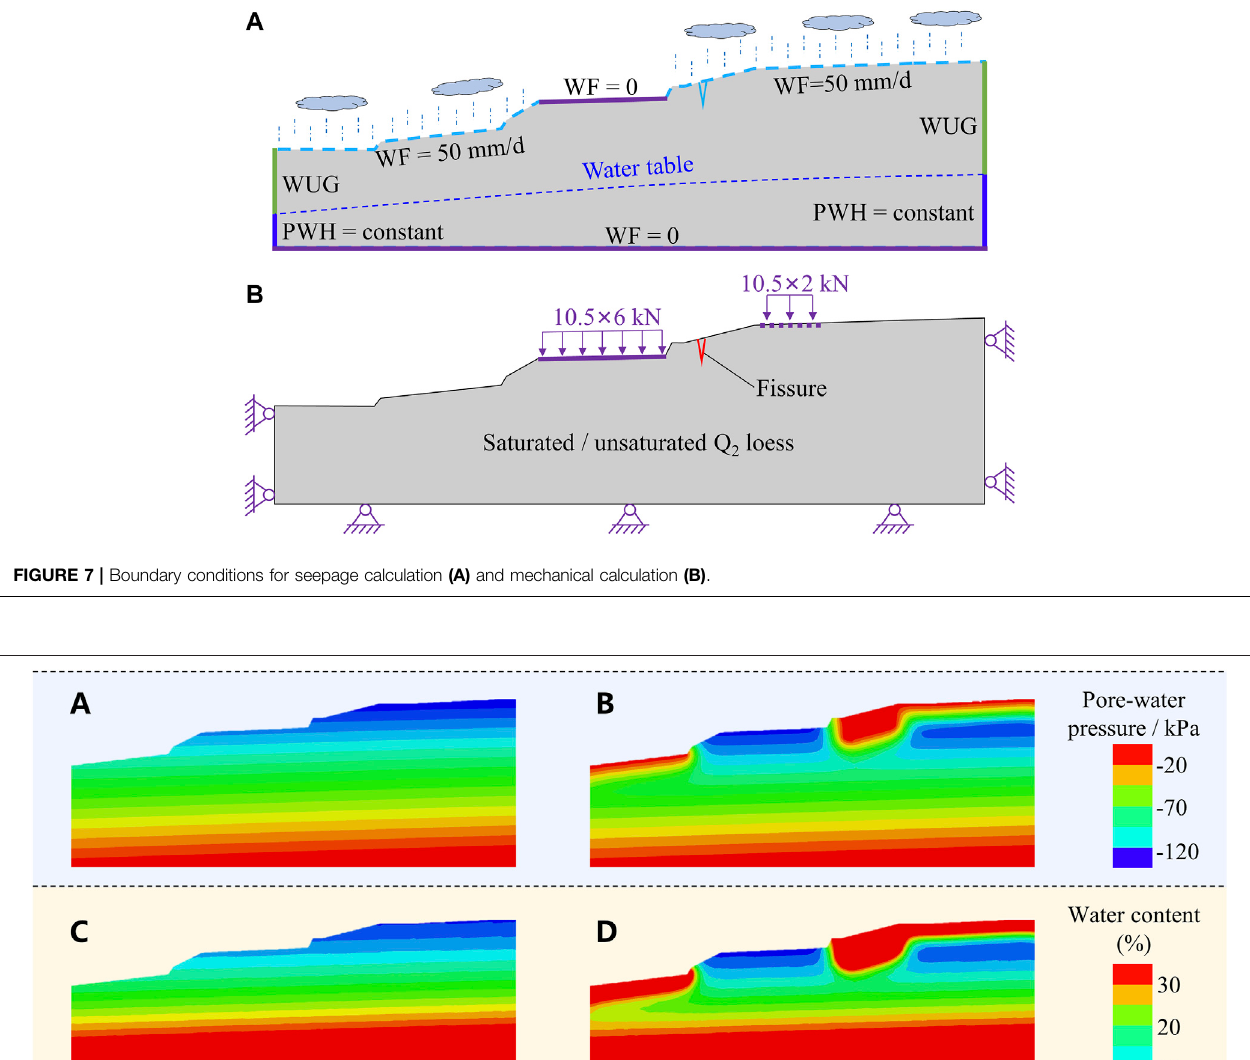
calculation results of the seepage. The modi fi ed constitutive for the mechanical calculation, and the material parameters,